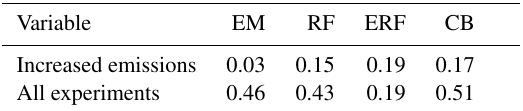
Table 3. Standard deviations for the different normalised basis quantities evaluated in Fig. 3b (unitless).